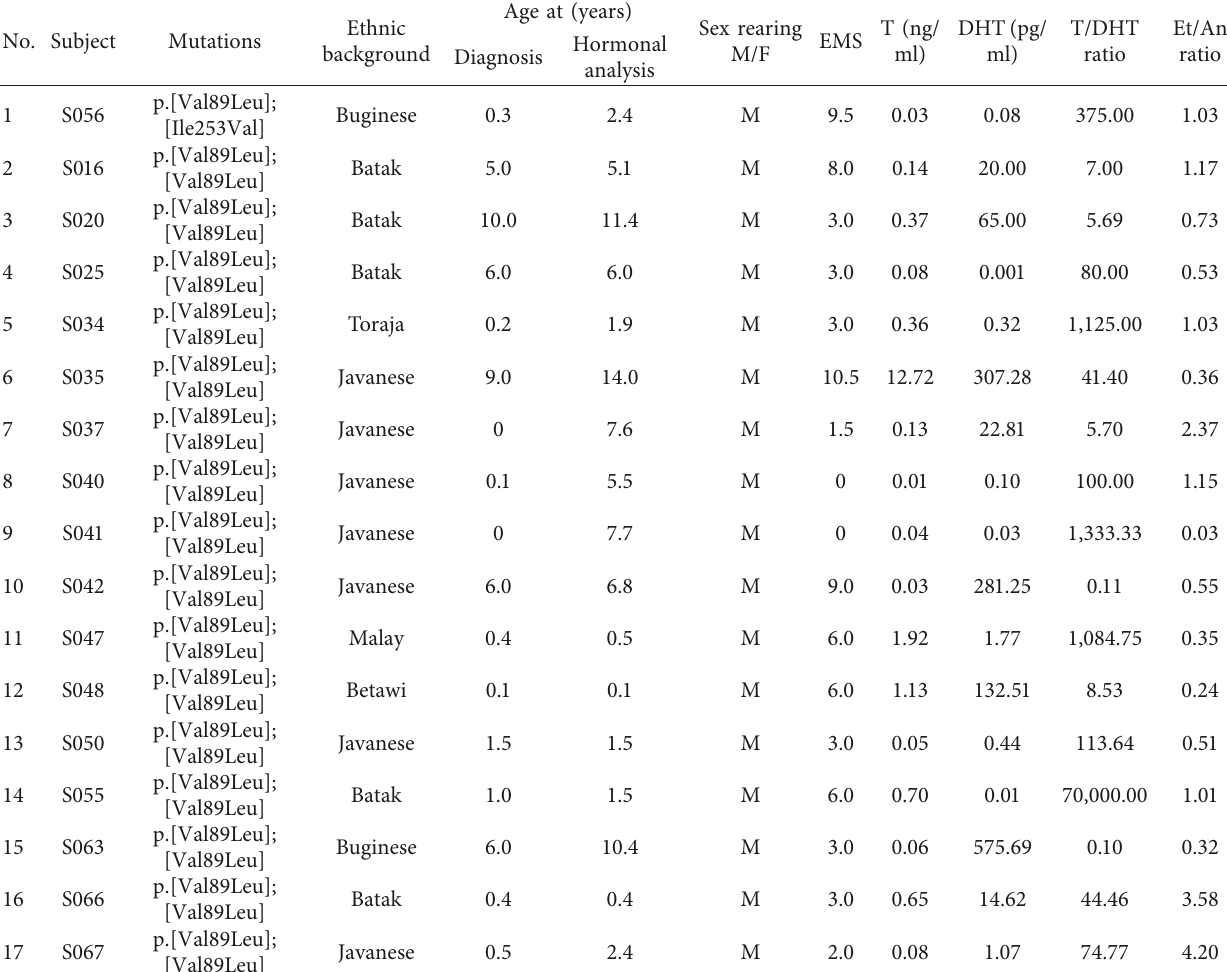
Table 3: Results from molecular, clinical, and hormonal analysis of subjects carrying benign mutations in both